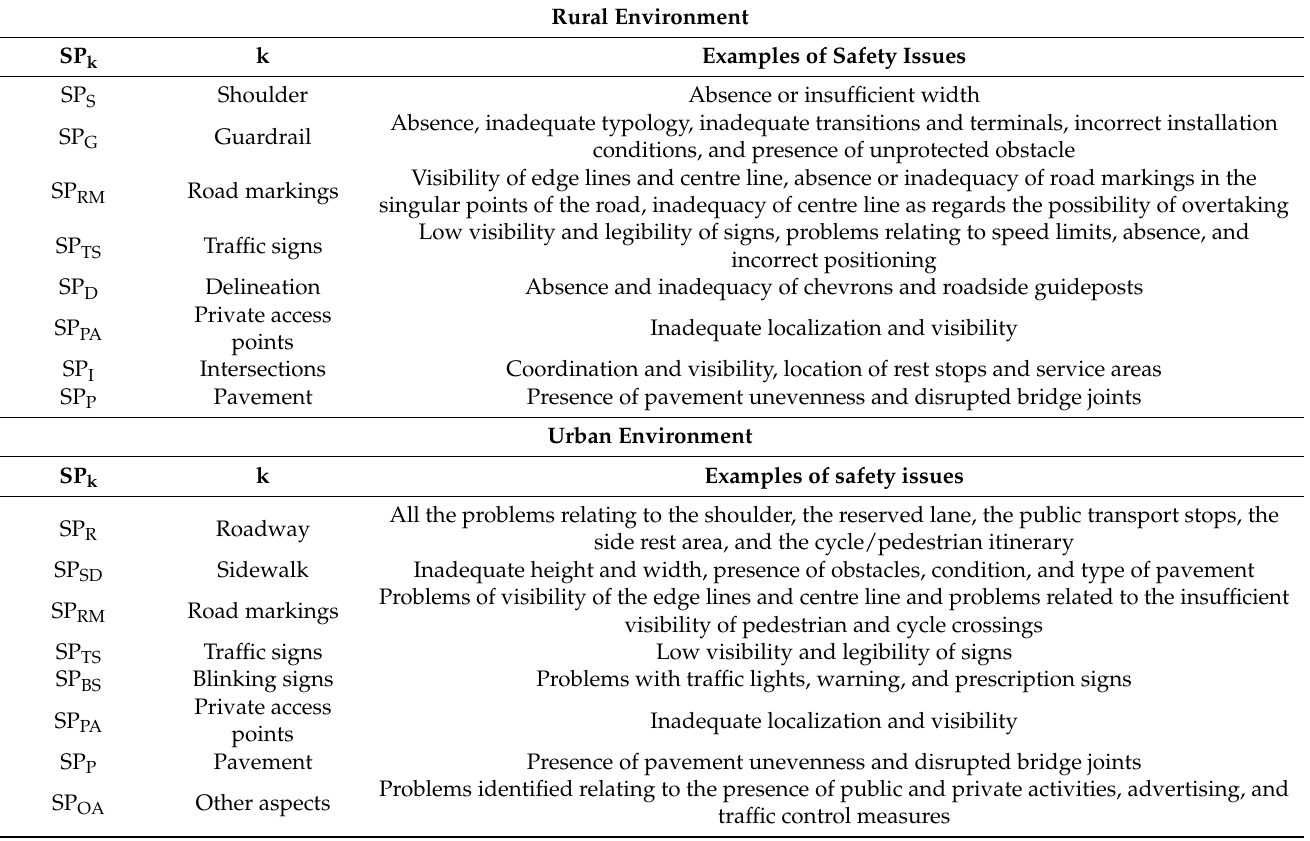
Table 3. Main safety issues for the evaluation of the parameter k for rural and urban environments. Rural Environment Examples of Safety